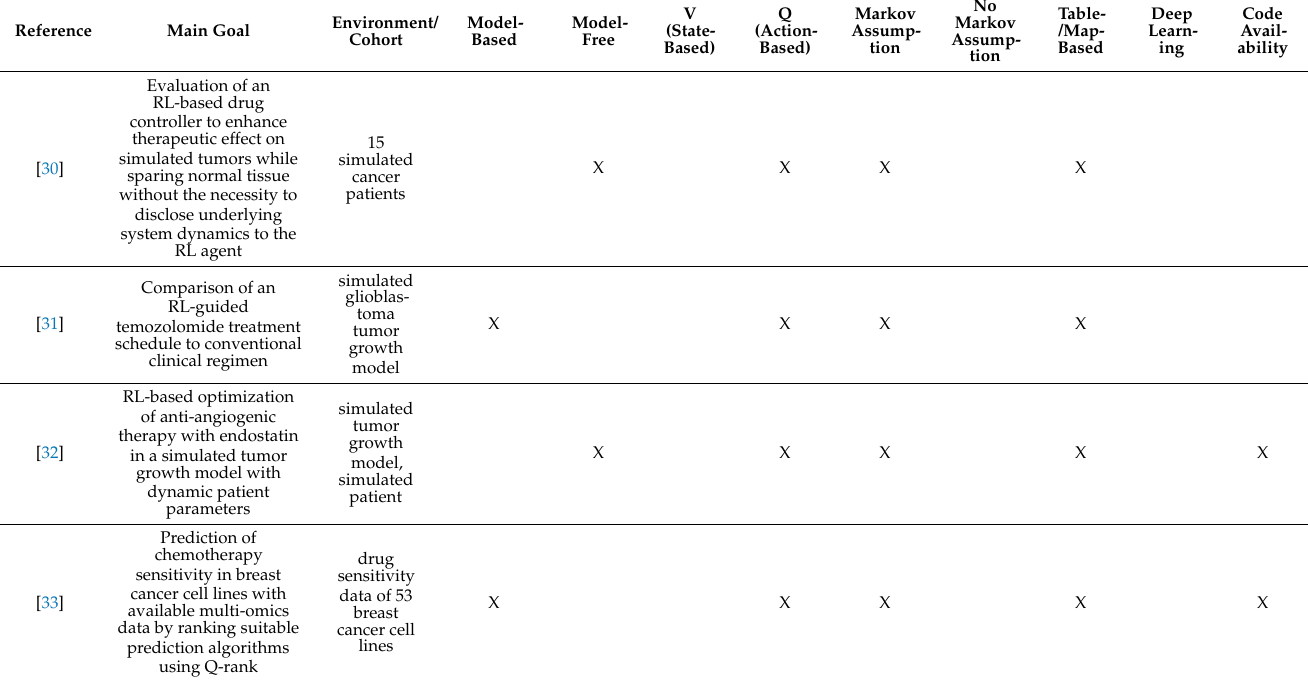
Code Table- /Map- Avail- Based